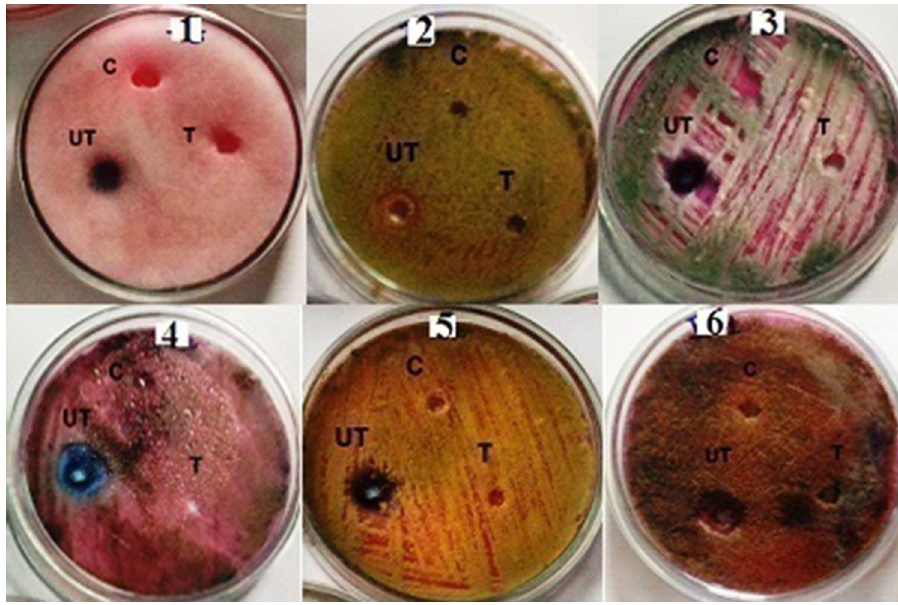
Table 3 Root length of Allium cepa grown in control, untreated and S. wightii -treated BG dye solution